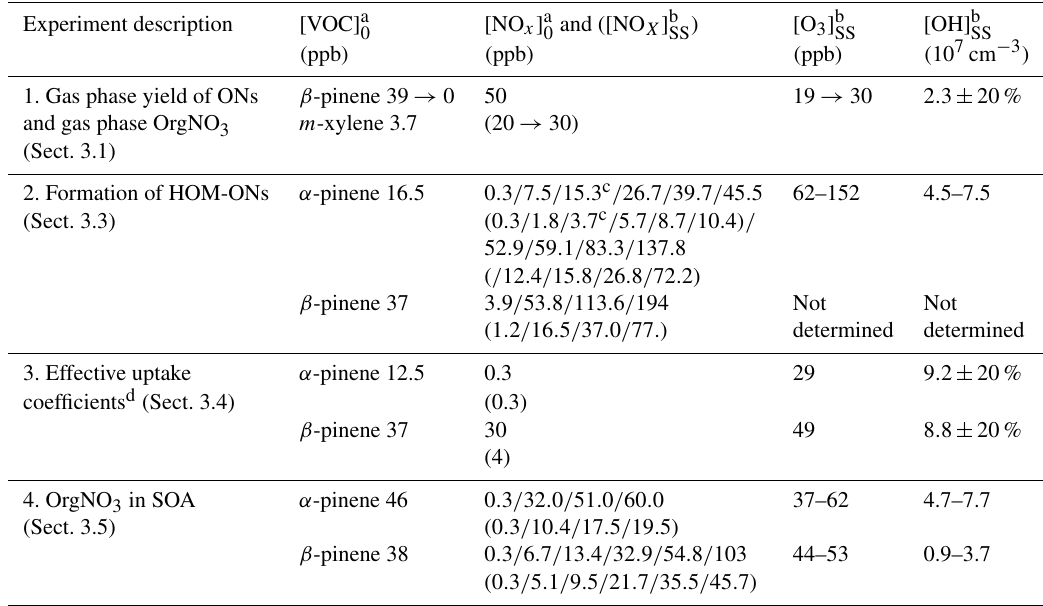
Table 1. Overview of α -pinene and β -pinene experiments. Experiment